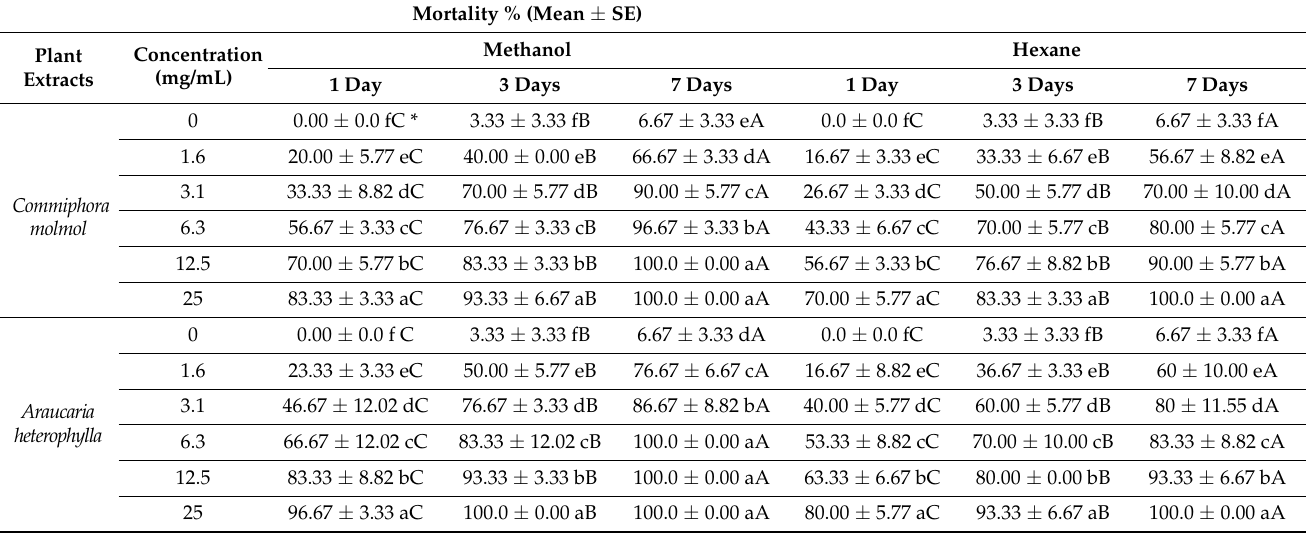
Table 3. Efficacy of the plant extracts Commiphora molmol and Araucaria heterophylla on Cattle ticks, Rhipicephalus (Boophilus) annulatus .